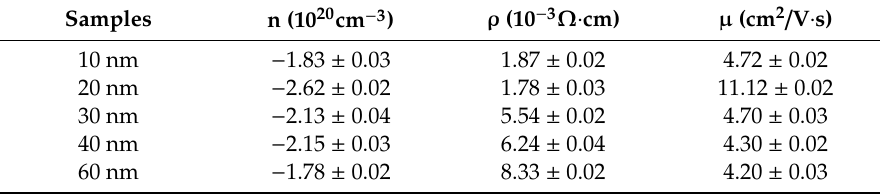
Table 1. Hall e ff ect measurements of sputtered SnO 2 deposited on